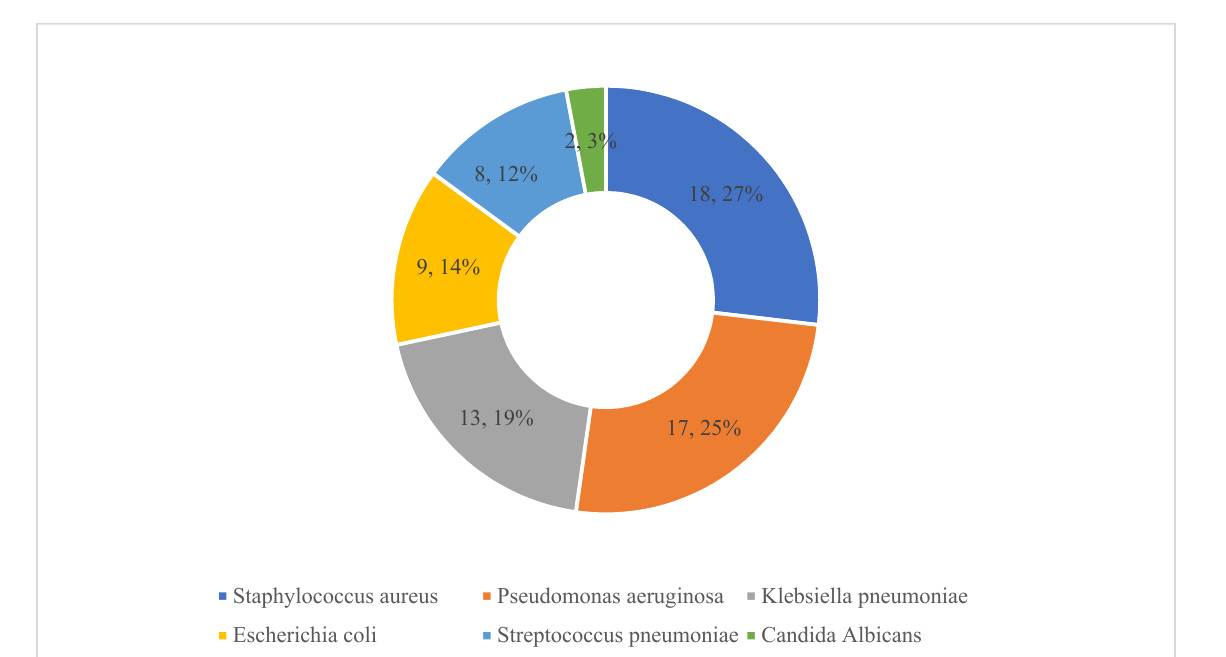
Figure 3. Details of microorganisms responsible for healthcare-associated infections. Note: The numbers refer to the number of patients with these isolates along with the percentages ( n = 67).